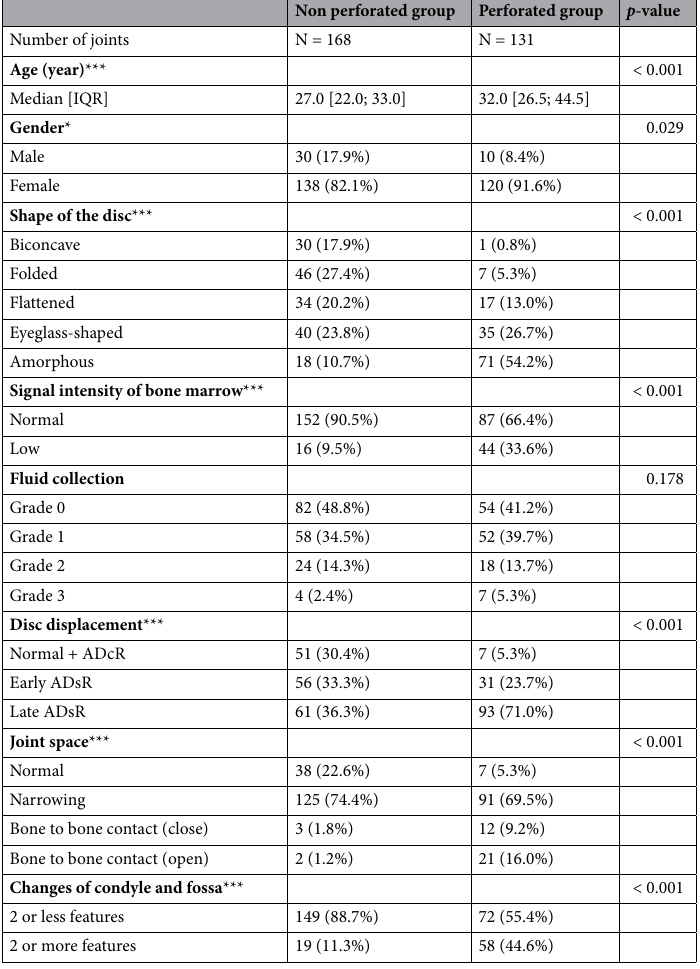
Table 1. Characteristics of study objects. IQR Interquartile range, ADcR anterior displacement with reduction, ADsR anterior displacement without reduction. * p < 0.05, ** p < 0.01, *** p <